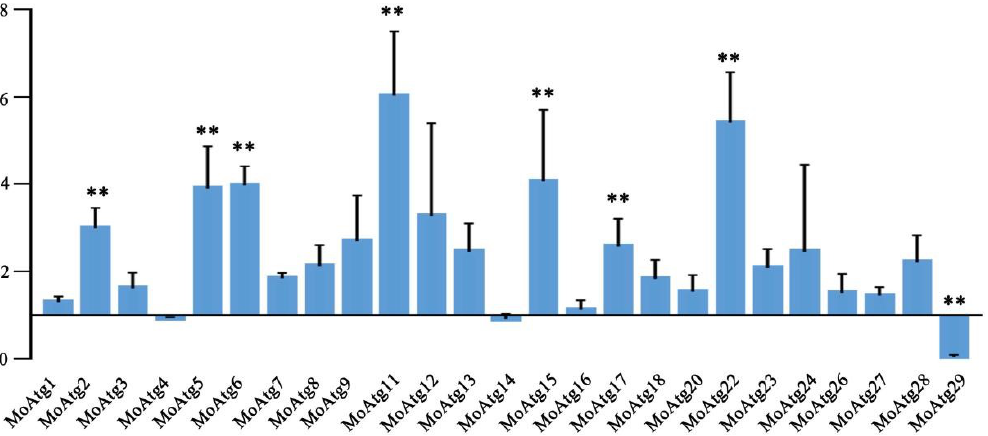
Figure 7. Analysis of the expression levels of core autophagy genes in M. oryzae . The relative mRNA levels of core autophagy genes ( MoATG1 /MGG_06393, MoATG2 /MGG_16734, MoATG3 /MGG_17909, MoATG4 /MGG_03580, MoATG5 /MGG_09262, MoATG6 /MGG_03694, MoATG7 /MGG_07297, MoATG8 /MGG_01062, MoATG9 /MGG_09559, MoATG11 /MGG_04486, MoATG12 /MGG_00598, MoATG13 /MGG_454, MoATG14 /MGG_03698, MoATG15 /MGG_12828, MoATG16 /MGG_05255, MoATG17 /MGG_07667, MoATG18 /MGG_03139, MoATG20 /MGG_12832, MoATG22 /MGG_09904, MoATG23 /MGG_10579, MoATG24 /MGG_03638, MoATG26 /MGG_03459, MoATG27 /MGG_02386, MoATG28 /MGG_08061, MoATG29 /MGG_02790) were quantified using qPCR, and the results were normalized to α -ACTIN expression and compared to the WT results in the aerial mycelia of ∆ Mokns1 mutant. Error bars represent standard deviation. Significant differences compared with the WT were estimated using Duncan’s test (** p < 0.01).